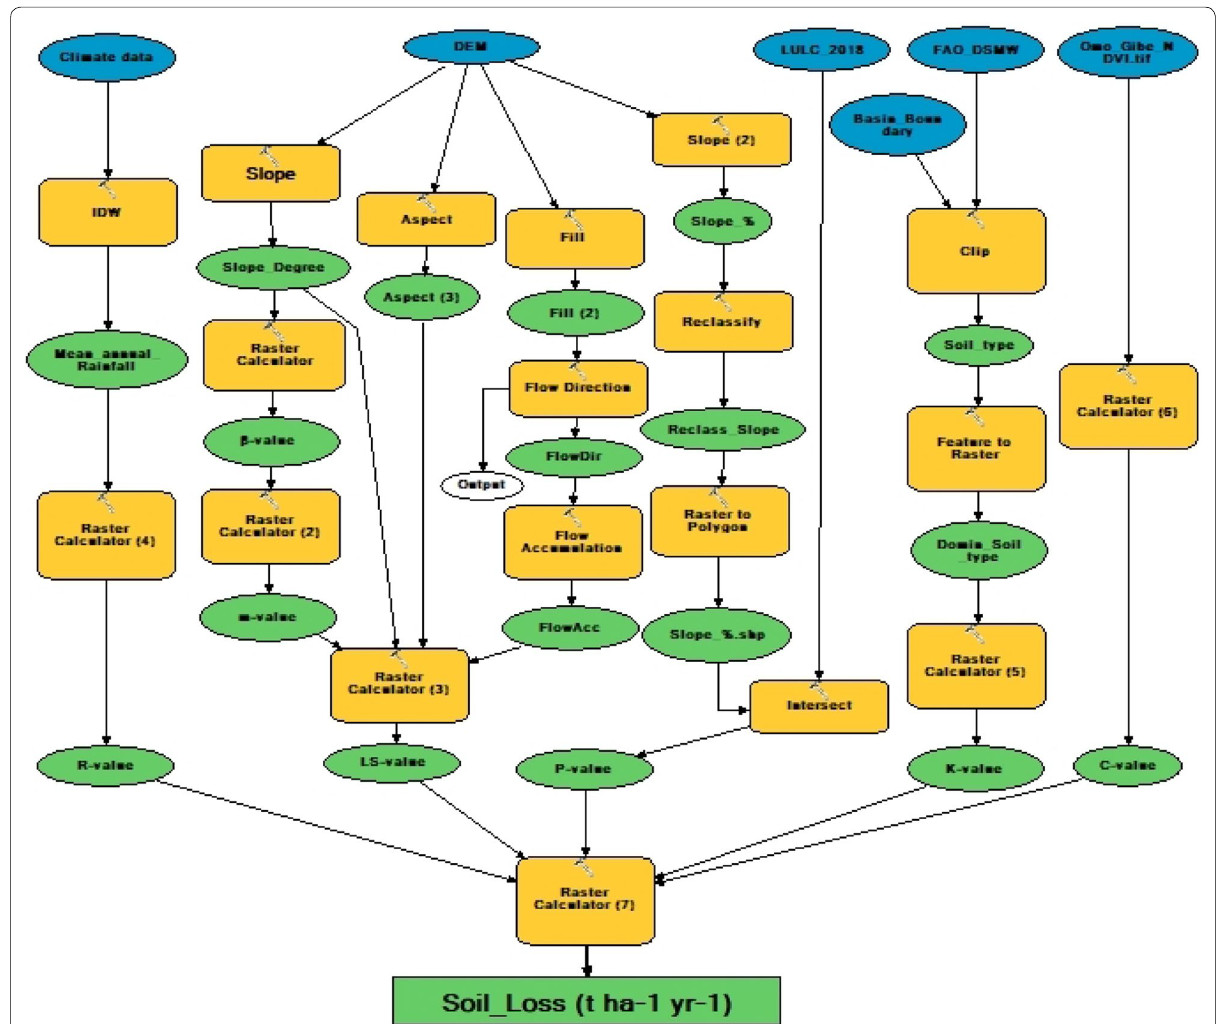
Fig. 2 The GIS-RUSLE interface framework implemented in this